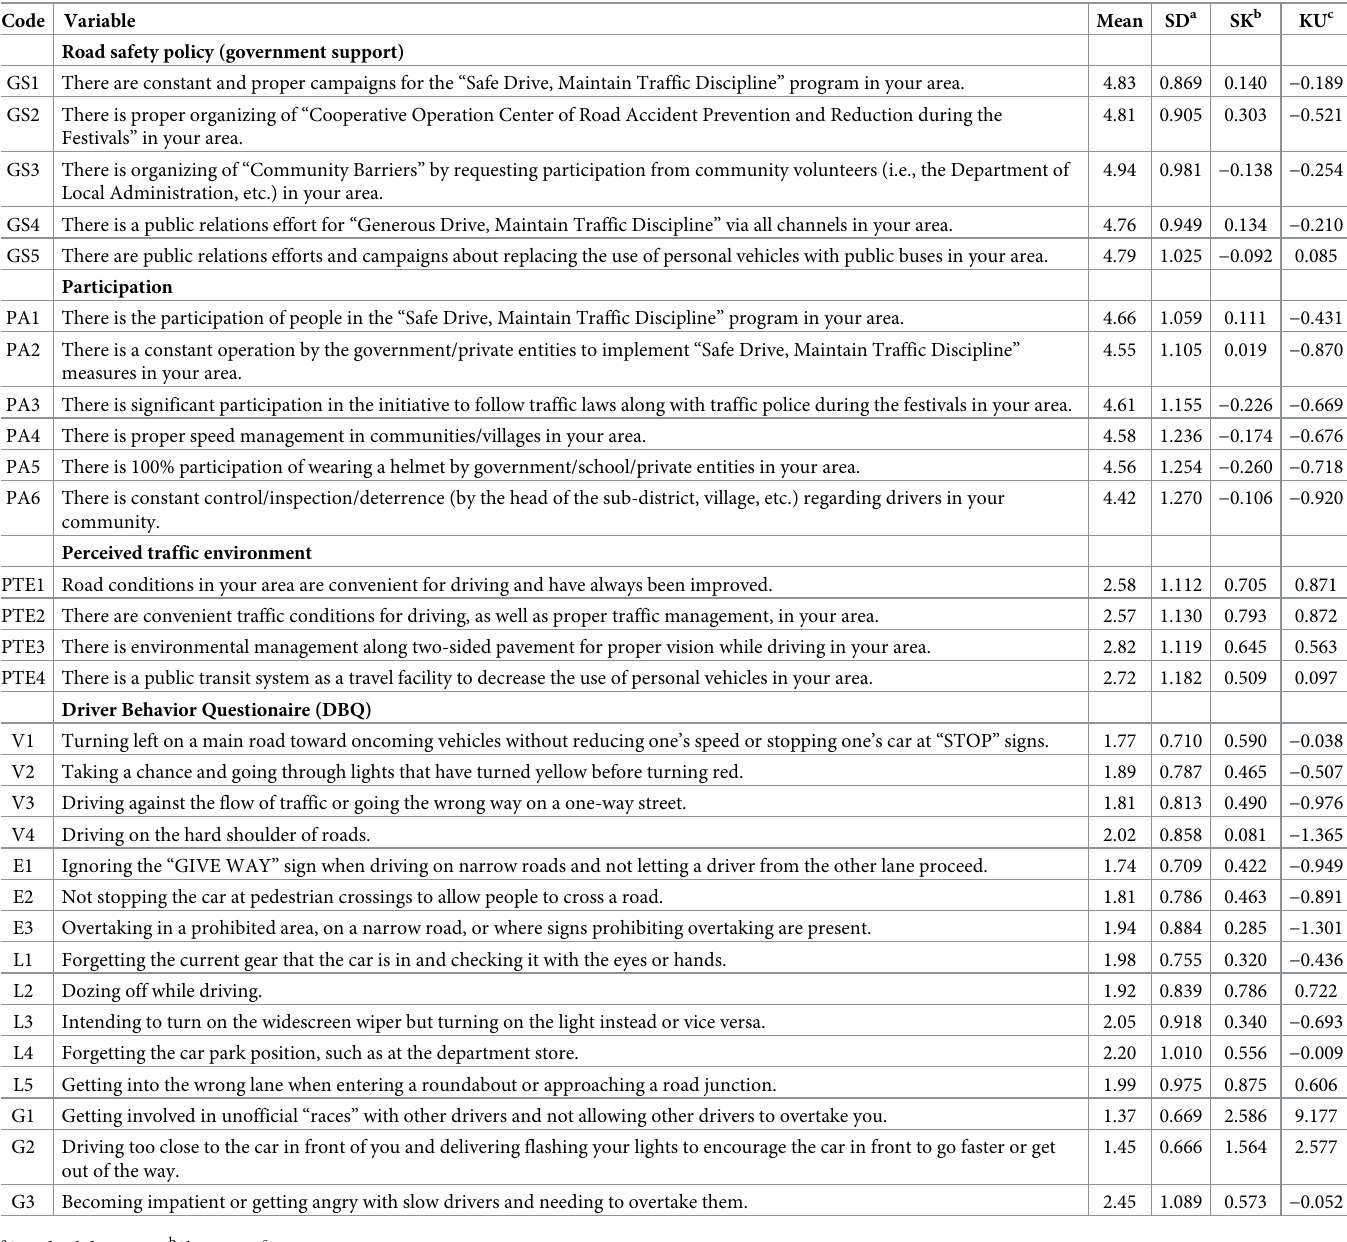
Table 3. Sample statistics; N = 1,474. Code